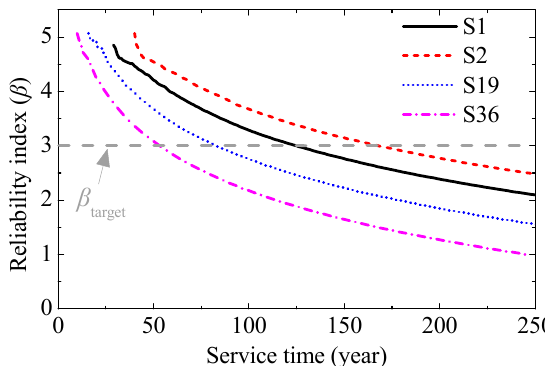
Figure 11. Fatigue reliability index of the four representative suspenders.